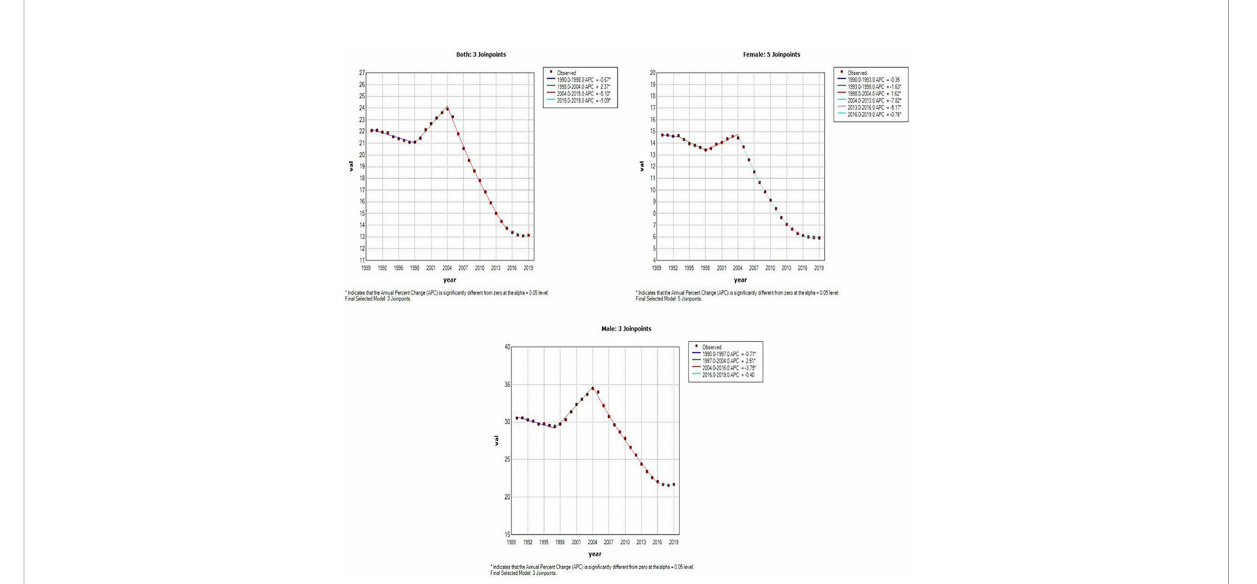
FIGURE 4 Joinpoint analysis of trends in the age-standardized mortality rates (ASMR) of Esophageal